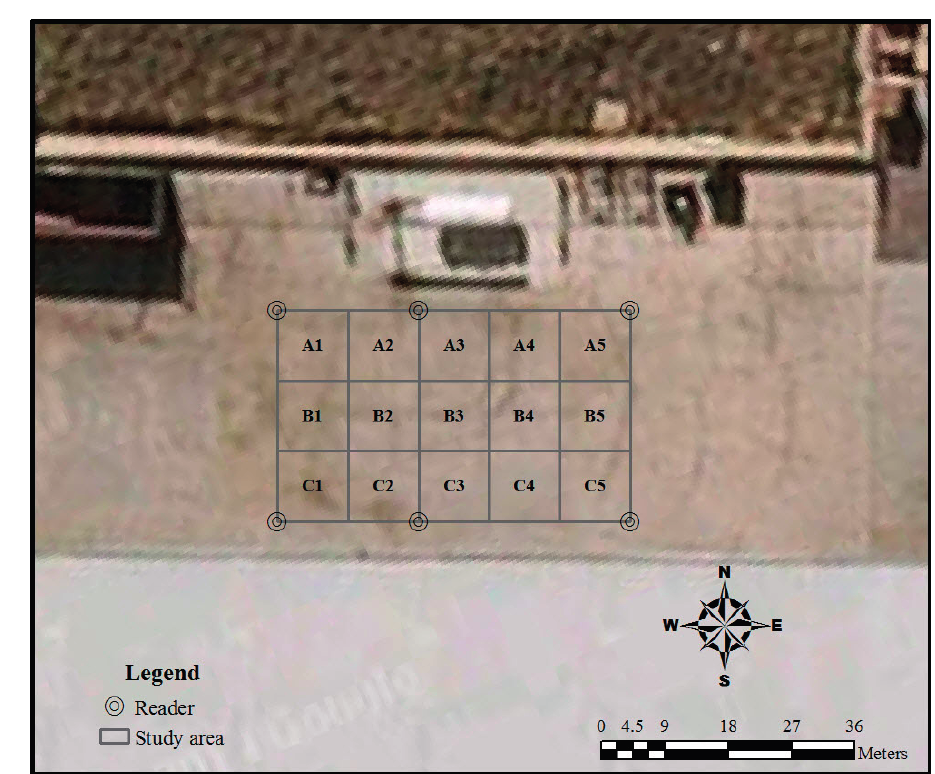
Figure 2. Sub-divided study areas with their